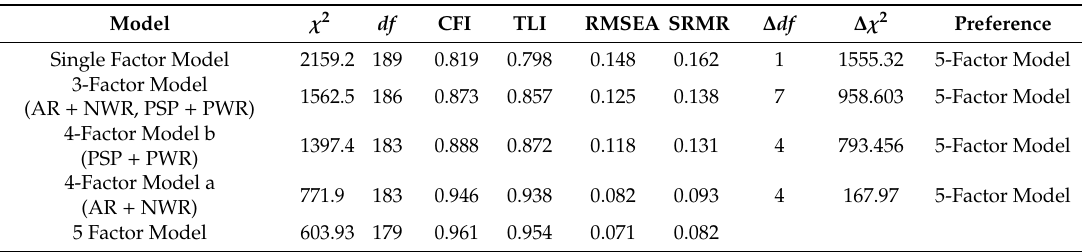
Table 3. Recommendation for fit